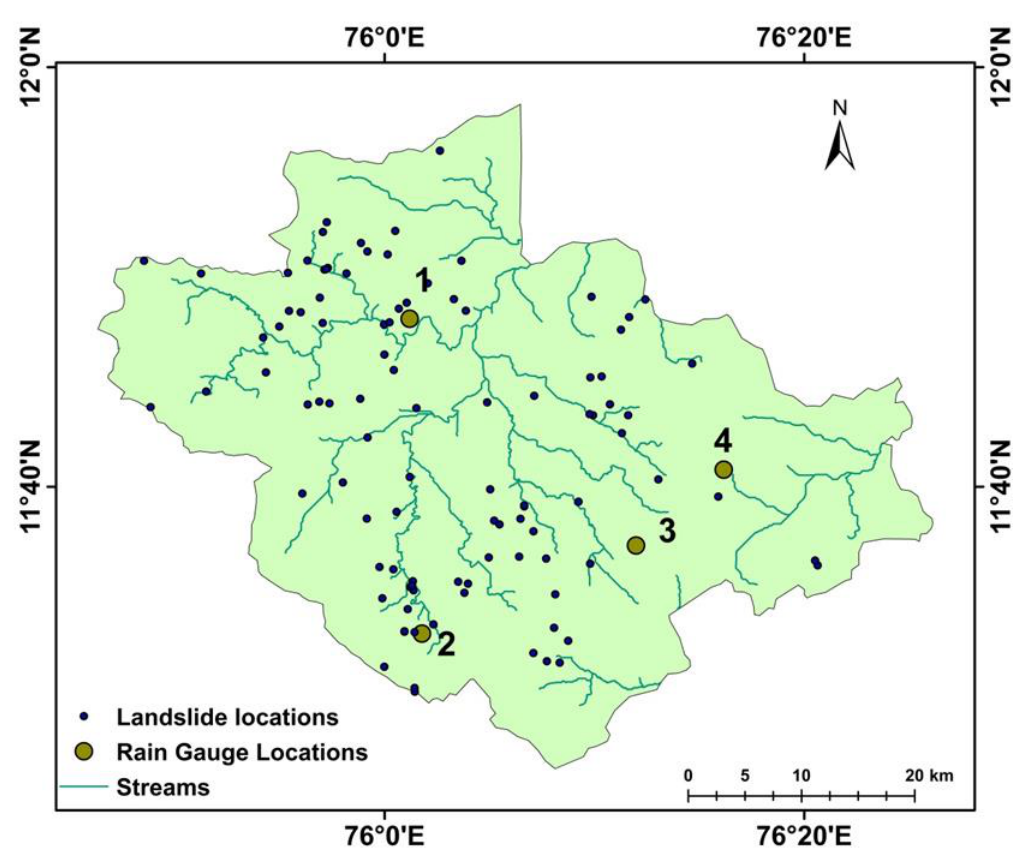
Figure 3. Drainage map of Wayanad overlaid by locations of landslides and rain gauges considered for analysis.